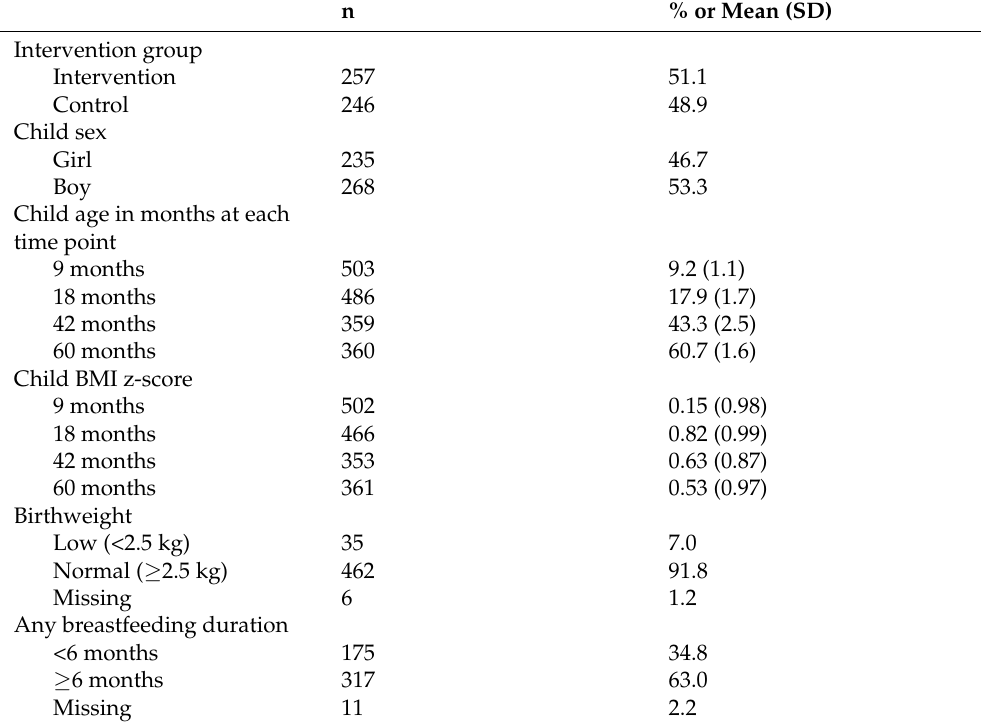
Figure 1. Flowchart of the study population. * child sex, birthweight, breastfeeding, introduction to solid food, and maternal employment status, education, country of birth and weight status, intervention group but excluding the variable assessed. Table 1. Characteristics in the Melbourne Infant Feeding Activity and Nutrition Trial Program (n = 503).